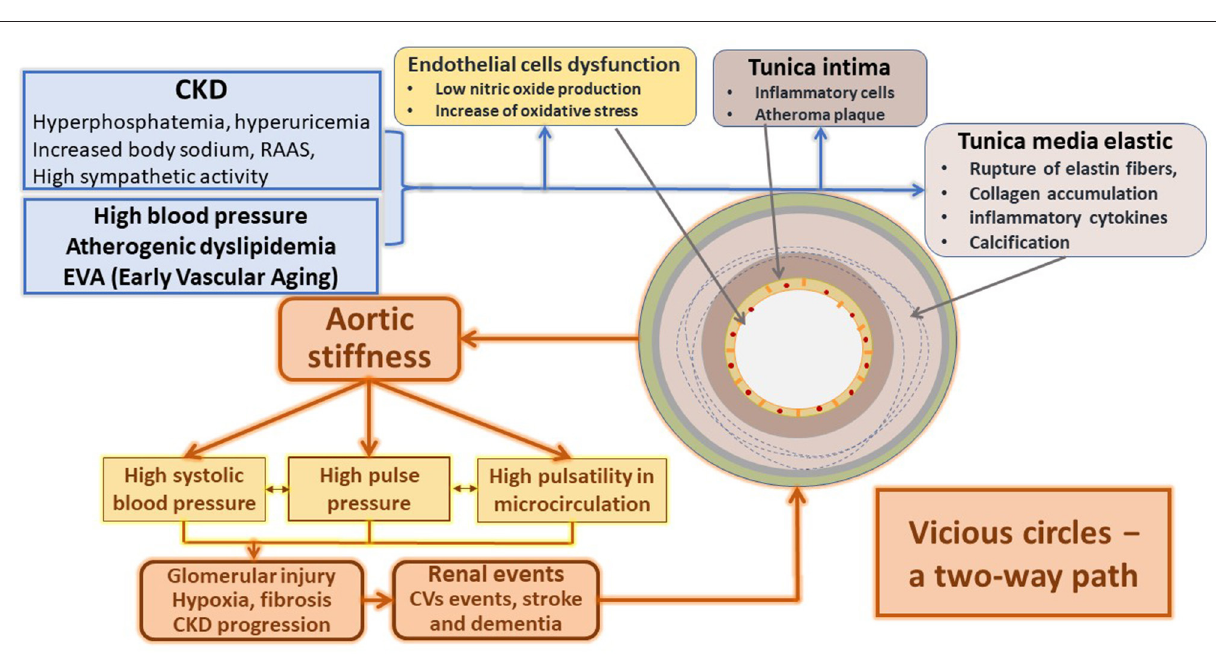
independently associated with mortality in CKD patients after adjusting for additional confounders, including inflammation